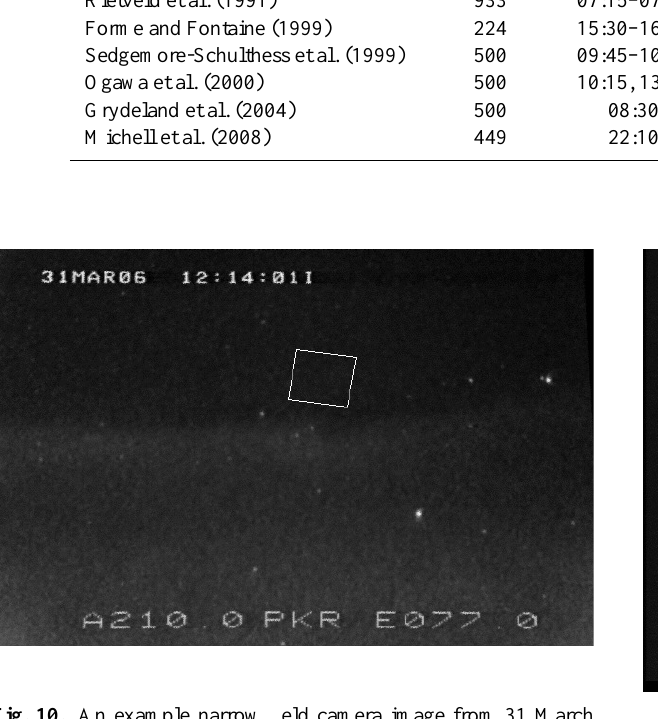
Fig. 10. An example narrow field camera image from 31 March 2006, showing the lack of filamentary dark auroral structures present in the magnetic zenith during a time when the poleward edge of the aurora crossed the magnetic zenith (near 12:14UT) and no NEIALs were observed. North is up and east is to the left. The PFISR field of view is marked by the white box near the center of the image.